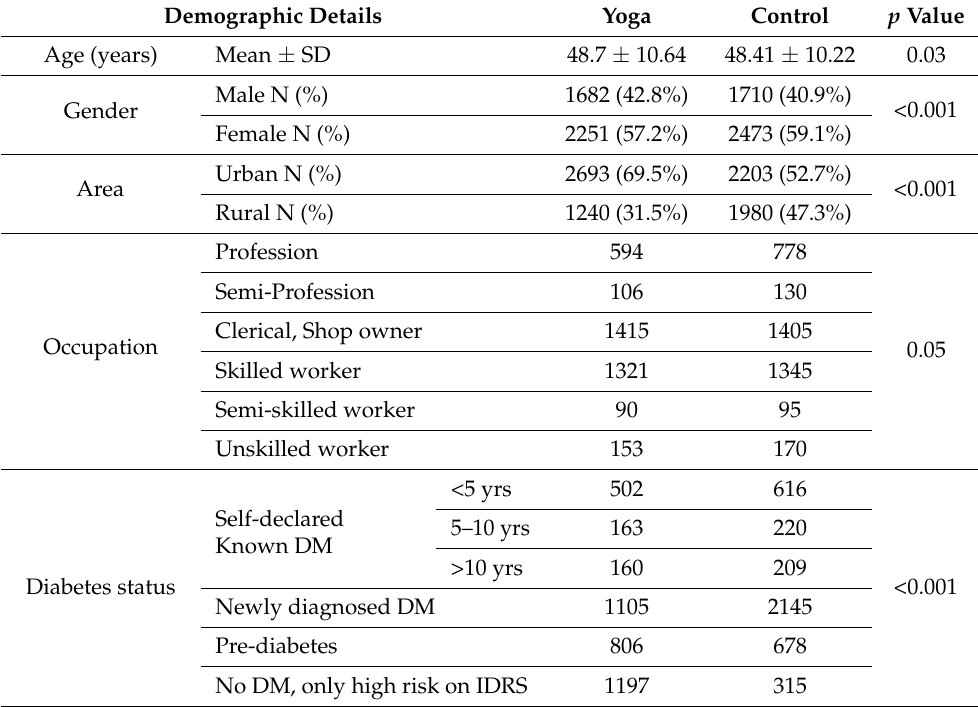
Table 1. Demographic details of yoga and control